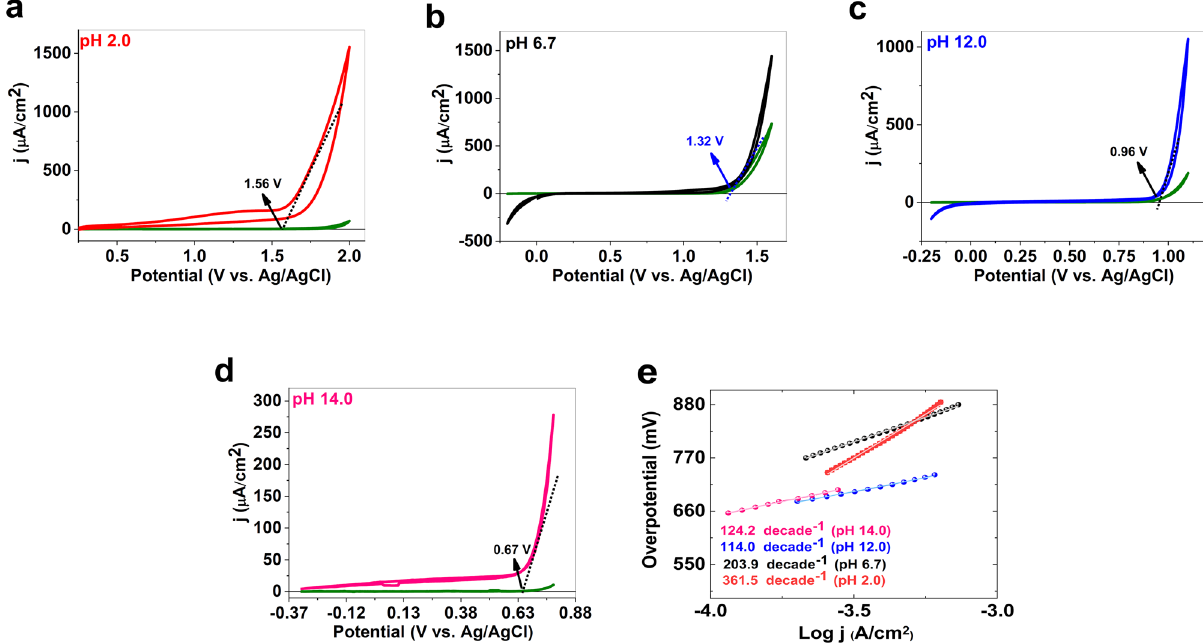
Figure 4. CVs (scan rate 25 mV/s) of 1 in pH 2 (phosphate buffer) ( a ), 7 (phosphate buffer) ( b ), 12 (phosphate buffer) ( c ) and 14 (KOH). Data for a bare FTO are shown in green. Tafel plots for 1 in pH 2 (red), 7 (black), 12 (blue), in bufferic phosphate solution and 14 (pink) in